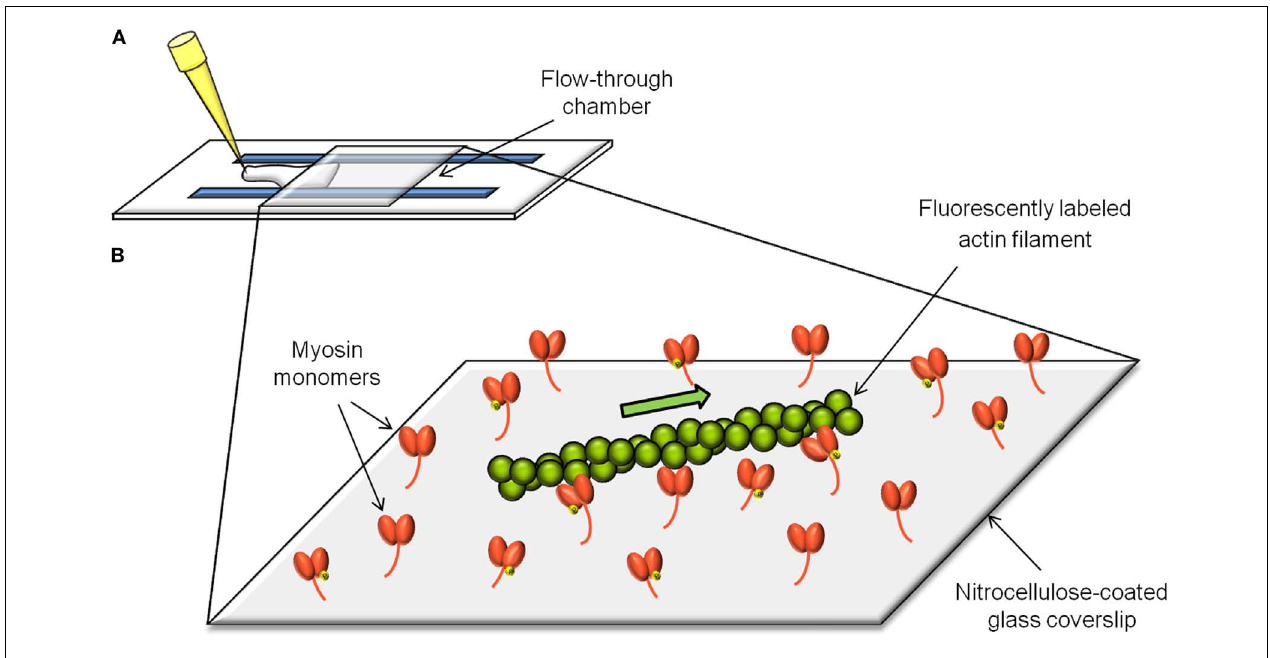
flow-through chamber to setup and perform the assay is constructed from a nitrocellulose-coated coverslip and a microscope slide separated by plastic shims (A)